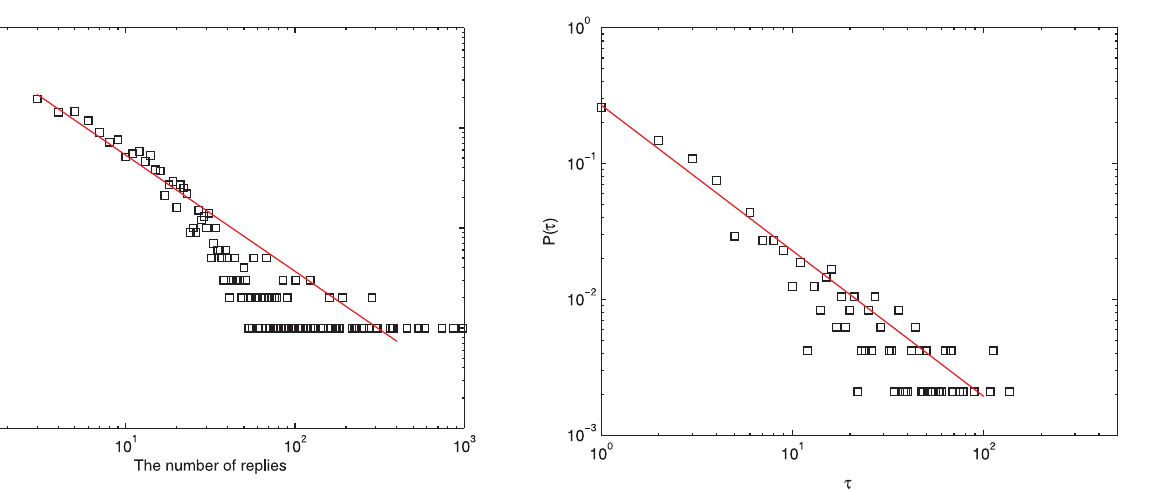
Figure 6. Distribution of waiting time between consecutive threads published by a typically selected user after 5000 time steps, N ~ 1000 , l ~ 0 : 001 , d ~ 0 : 5 . The distribution of the time differences between consecutive threads published by a typically selected user is approximated by P t ð Þ * t a where a ~{ 1 : 073 + 0 : 056 , indicating that a user activity pattern has non-Poisson statistics.